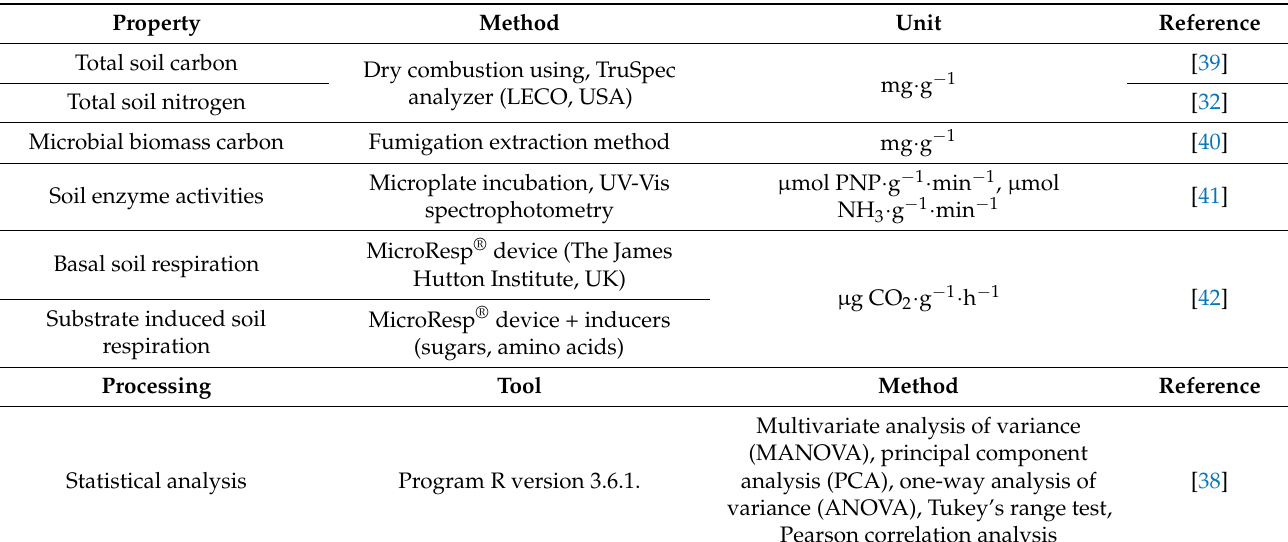
Table 4. Determined soil properties, methods used for measurement and statistics, relevant references.